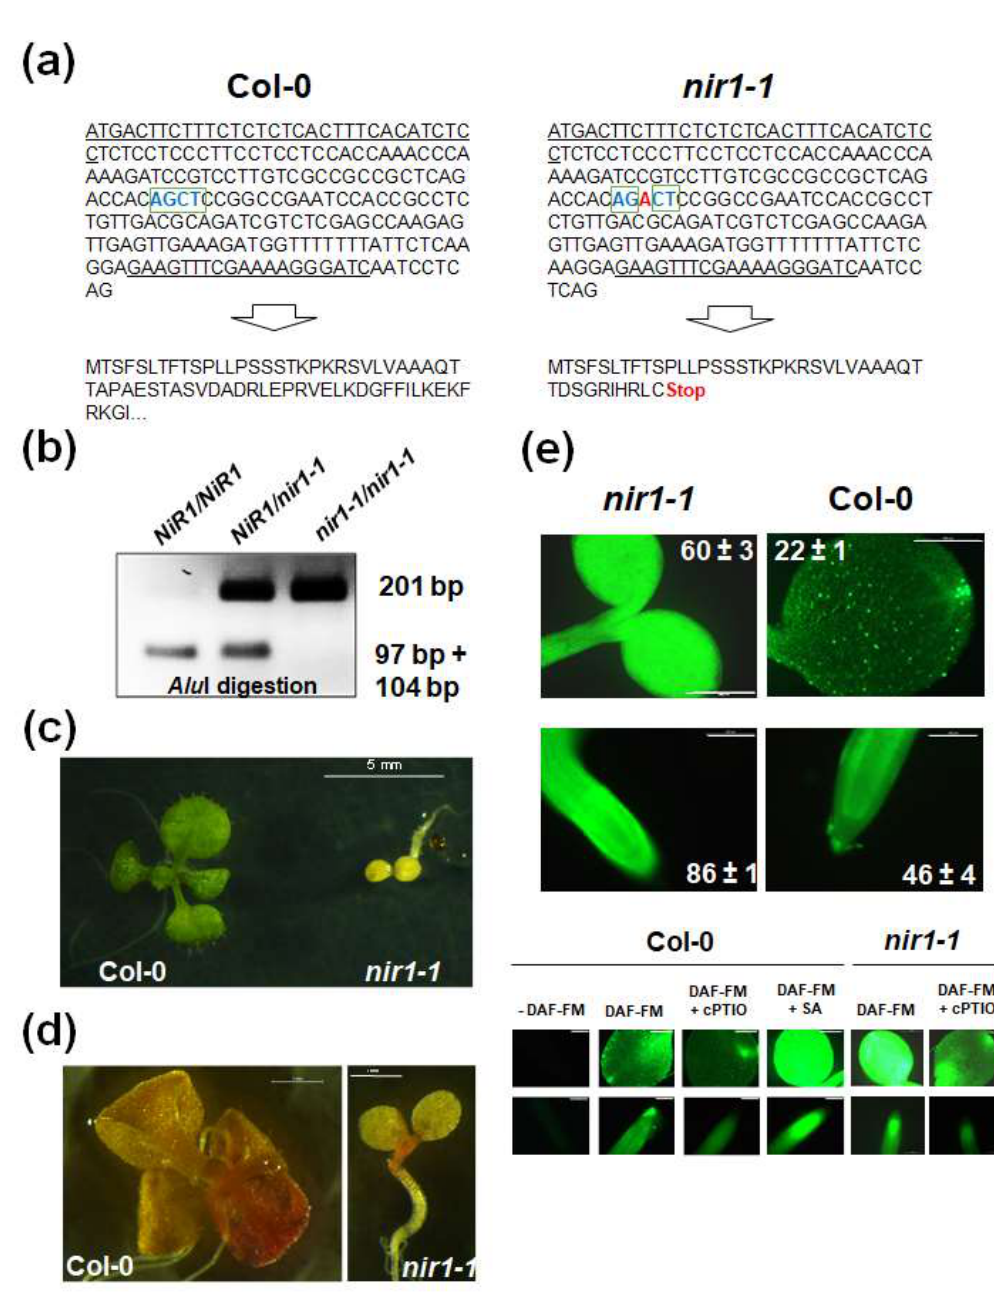
Figure 1. Generation of nir1-1 mutant plants by CRISPR/Cas9 gene editing. ( a ) 5′sequence of the NiR1 locus showing the A (red) insertion generating a Restriction Fragment Length Polymorphism with the disruption of an Alu I restriction site and, as shown in the translated amino acid sequences, the generation of a premature stop codon in the mutant plants. ( b ) PCR-assisted genotyping of progeny using the primers corresponding to the underlined sequences in panel a. The ethidium bromide stained 2% agarose gel is shown ( c ) Extreme stunted and chlorotic phenotype shown by homozygous nir1-1 plants. ( d ) Nitrite staining after treatment with sulfanilamide and N-(1-naphtyl)-ethylenediamine. ( e ) Endogenous levels of NO in wild type Col-0 and nir1-1 mutant plants. Images are representative of cotyledons (upper panels) and roots (lower panels) of each genotype and condition tested after treatment with 4-Amino-5-Methylamino-2',7'-Difluorofluorescein Diacetate (DAF-FM diacetate). Images were captured with a Leica DM 5000B fluorescence microscope equipped with a chlorophyll auto fluorescence filter and digital camera. Scale bars correspond to 100 and 500 μm in roots and cotyledons, respectively. Values are the mean ± standard error of four independent replicates.